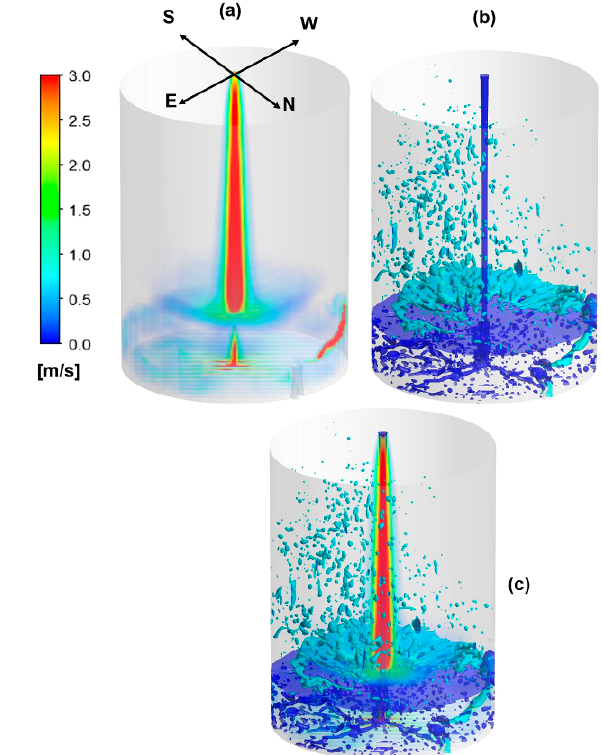
Figure 15. ( a ) 3D view of the velocity field ( b ) Dynamics of Interfaces air-argon, ( c ) 3D view of the velocity with interface air-argon. Bath level of 36 tons.